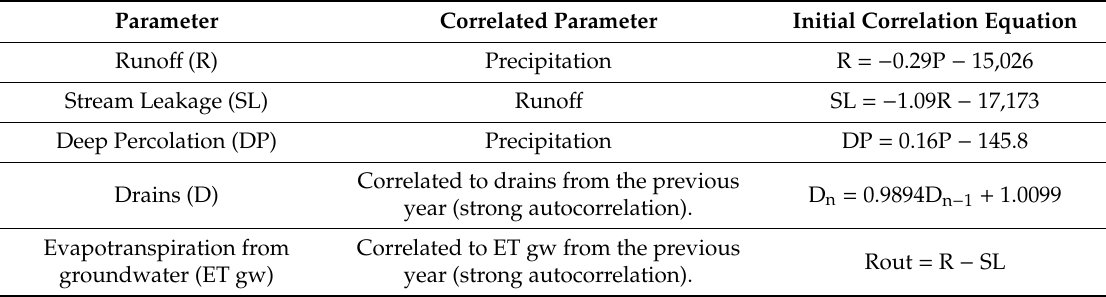
Table 3. Cuyama simulated parameters and correlation equations